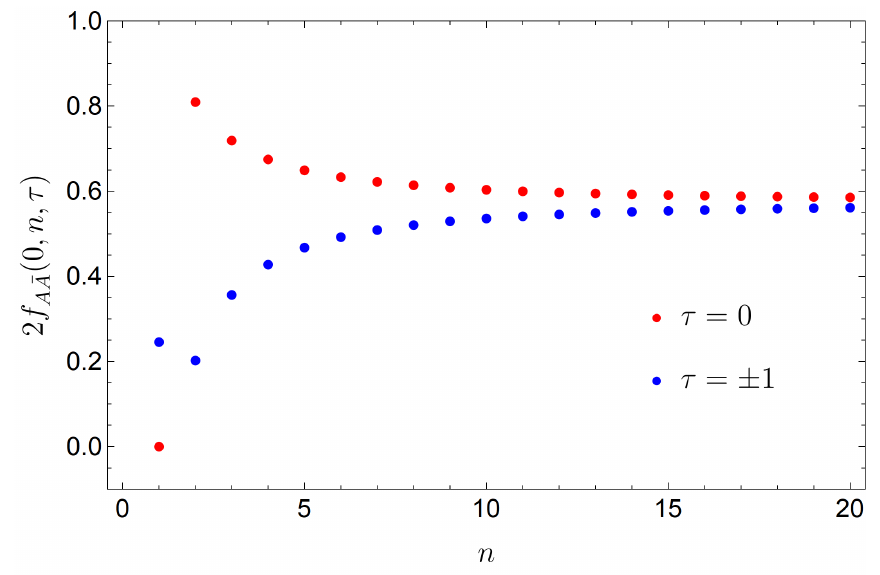
Figure 6 . 2 f (0 , n, τ ) is shown as a function of n both for the standard ( τ = 0 ) and CTFs A ¯ A ( τ = ± 1 ). As expected, its asymptotic value in the limit n → ∞ does not depend on τ